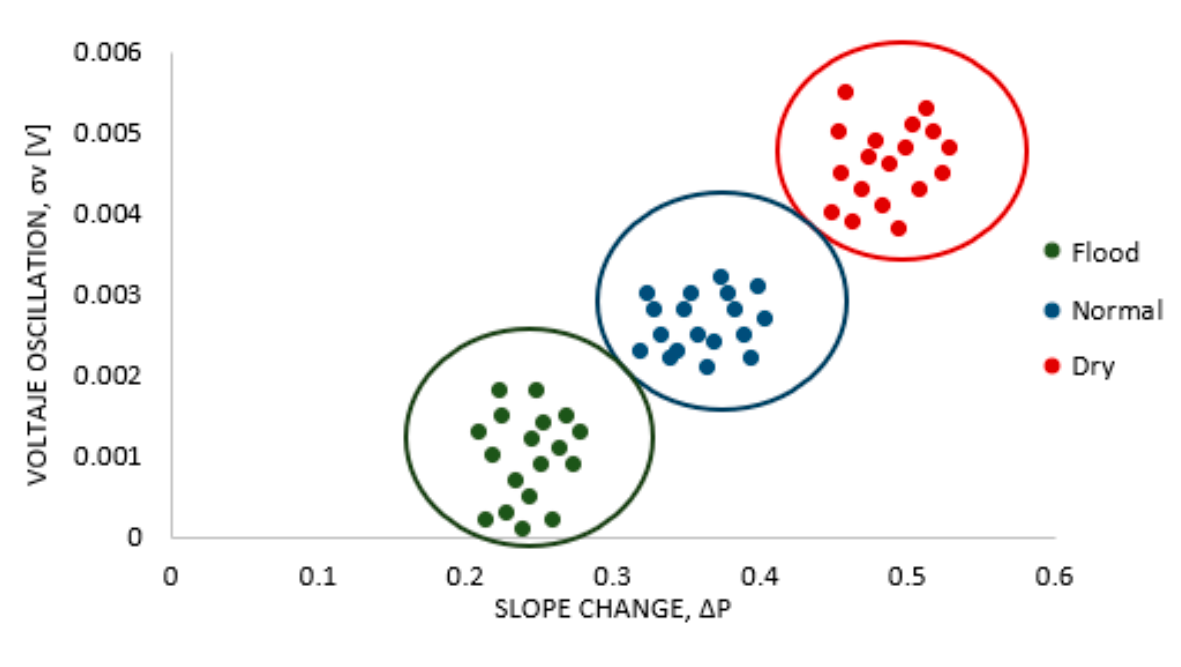
Figure 7. V-I polarization curves of the PEMFC, for different states. Figure 7 in turn provides a proof of concept that using this fuzzy method can better regulate water transport in the PEMFC. Starting from the dry state (Test 1), the low per- formance of the battery can be observed when supplying 60 mA. As humidified gas is introduced with a humidification time of 100%, it is observed that the response improves (from Test 2 to Test 8), in such a way that, when it reaches the optimal conditions of elec- tricity generation, the separation between curves consecutive V-I is decreasing. In the curve of Test 9, a voltage drop is observed as the stack is going from a normal state to a slightly flooded state. In the curve of Test 10, a recovery of the electrical response of the pile is observed, probably due to the disturbance of the two-minute flow jump, when dragging the water from the stack. 4.2. Results Validation